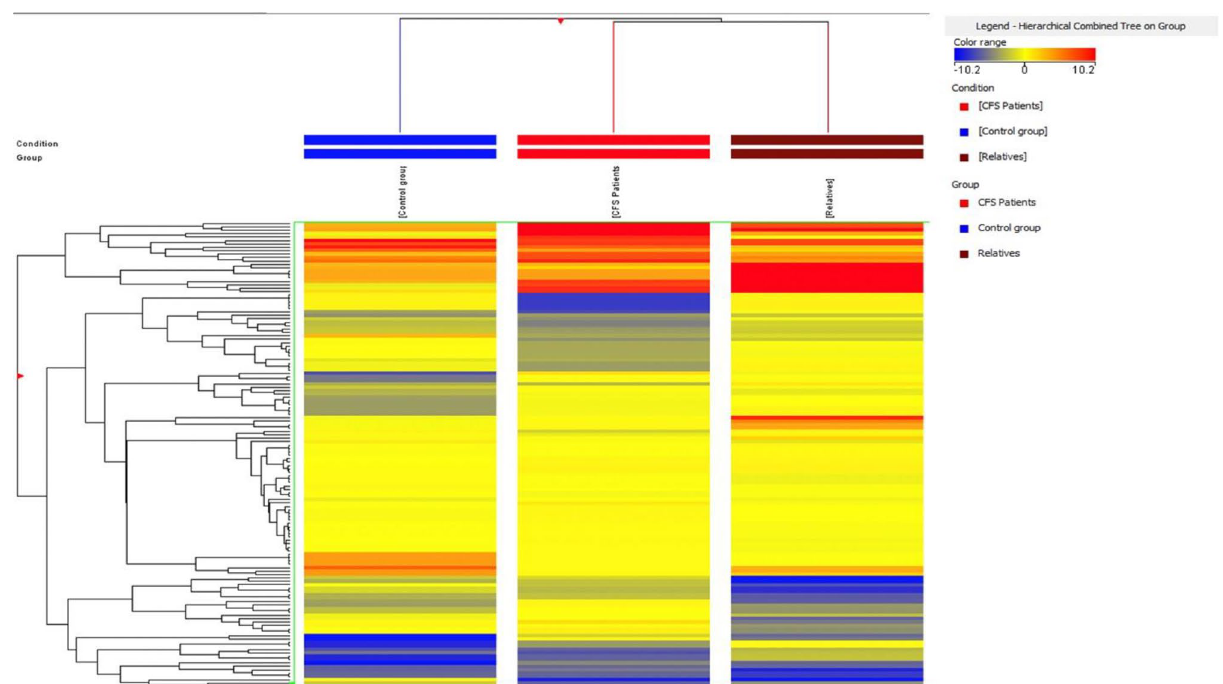
Figure 5. Unsupervised hierarchical cluster analysis (HCA) of identified metabolites in fecal samples of CFS/ ME patients, the relatives and the external healthy